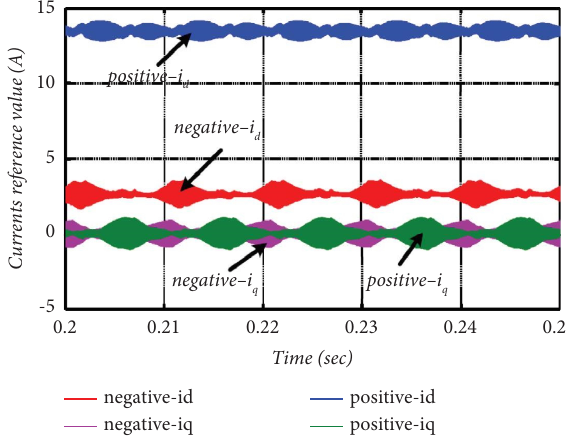
Figure 10: Positive and negative components on dq axis of input current using proposed controller under unbalanced grid